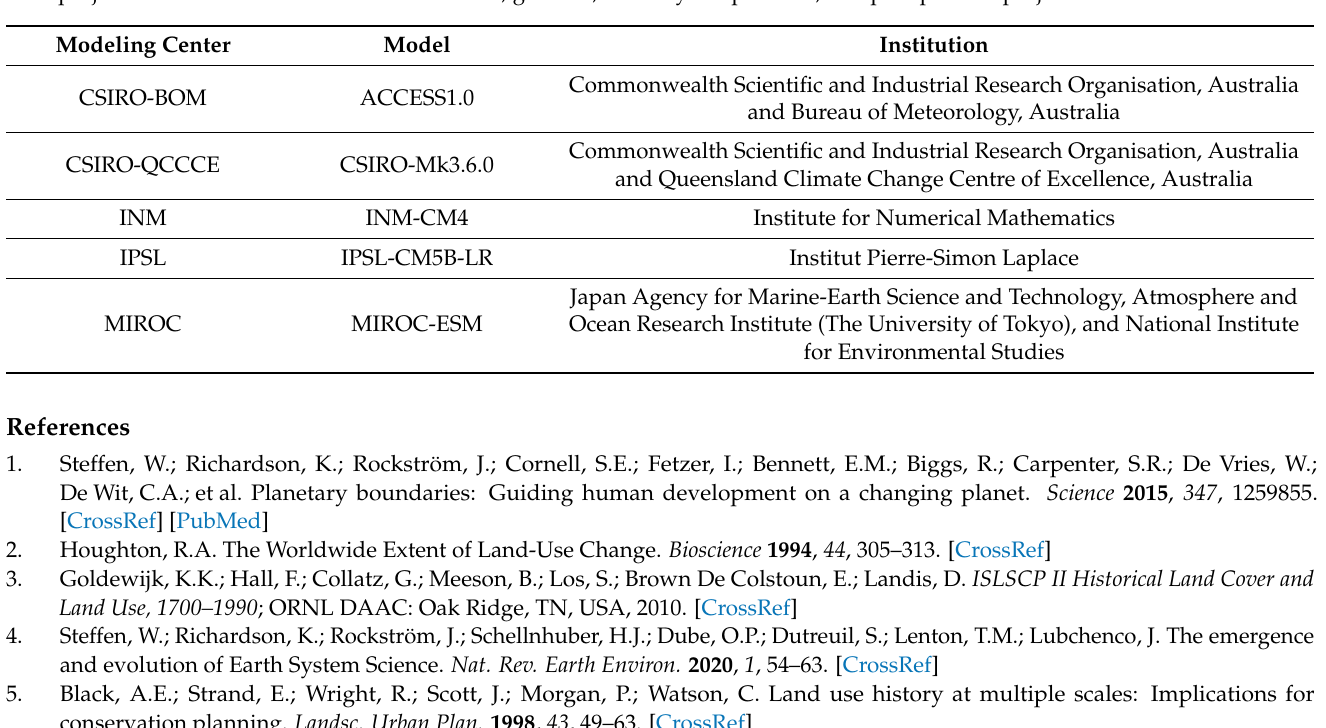
Table A2. Coupled Model Intercomparison Project Phase 5 (CMIP5) models providing unrestricted data used to compute projected climate variables from downscaled, gridded, monthly temperature, and precipitation